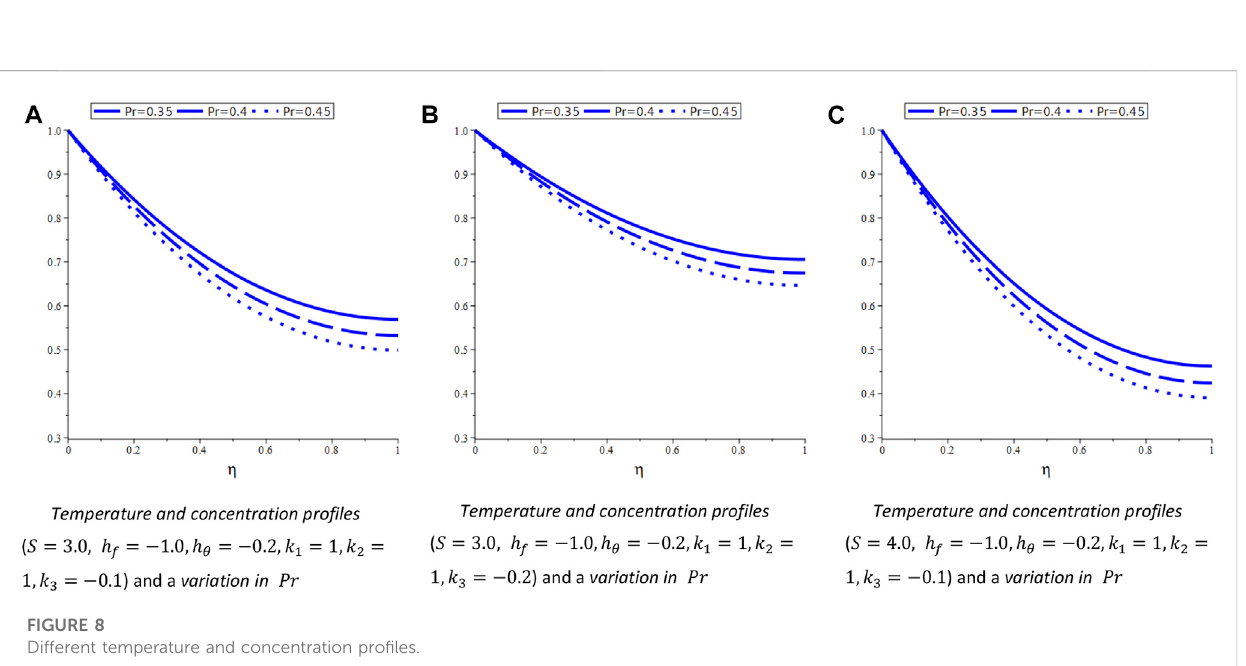
Different temperature and concentration pro fi